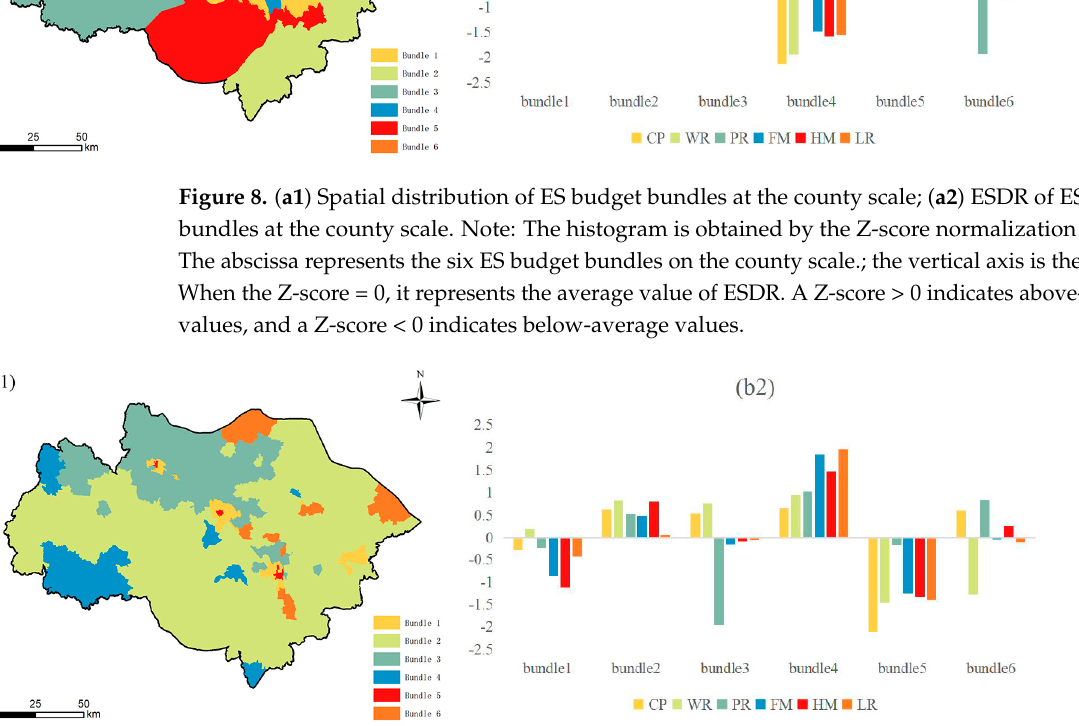
Figure 9. Spatial distribution of ES budget bundles at the township scale ( b1 ); ESDR of ES budget bundles at the township scale ( b2 ). Note: The histogram is obtained by the Z-score normalization method. The abscissa represents the six ES budget bundles on the township scale; the vertical axis is the Z-score. When Z-score = 0, it represents the average value of ESDR. Z-score > 0 indicates above-average values, and Z-score < 0 indicates below-average values.